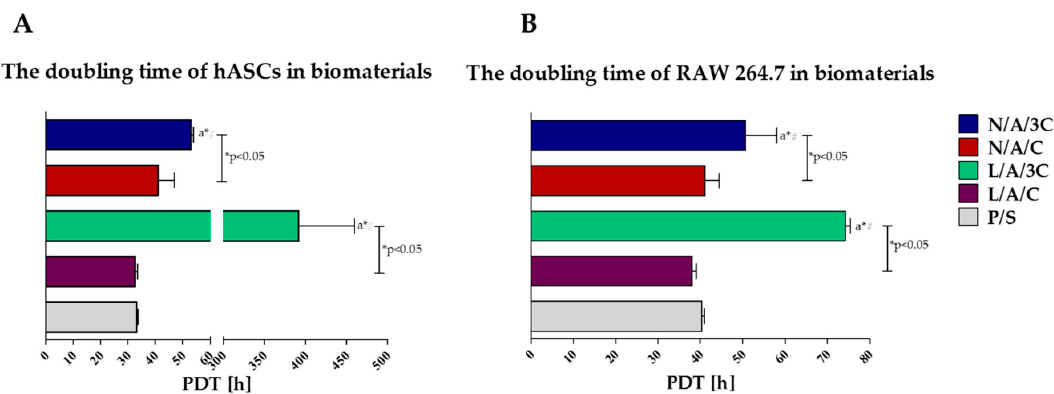
Figure 5. The doubling time of cells: ( A ) ASC; ( B ) RAW264.7. An asterisk (*) indicates a statistically significant difference ( p < 0.05) between biomaterials, while hashtag (#) in comparison to cultures on polystyrene (P/S).